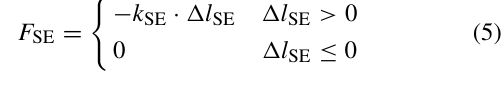
PDE: G¨unther&Schmitt[8]specifiedthefunctional dependency of the